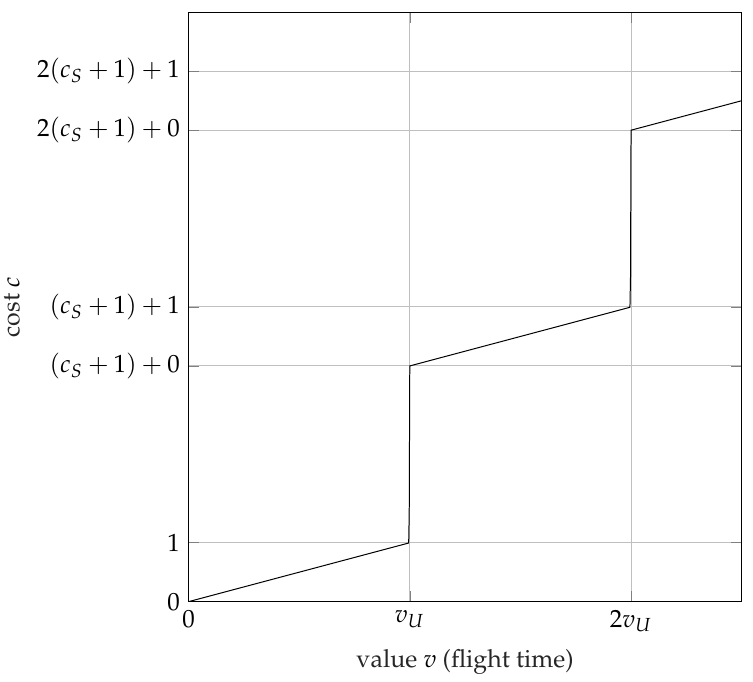
Figure 12. Step-type transfer function used to determine the cost related to flight